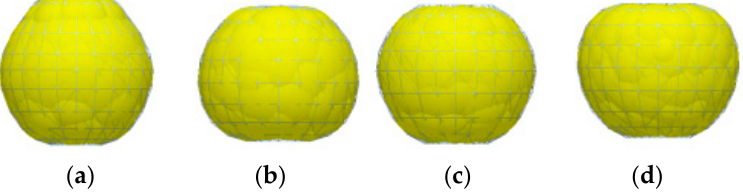
Figure 3. EDEM simulation models of typical pears. Snow pear ( a ); Crisp pear ( b ); Qiuyue pear ( c ); Huangguan pear ( d ).